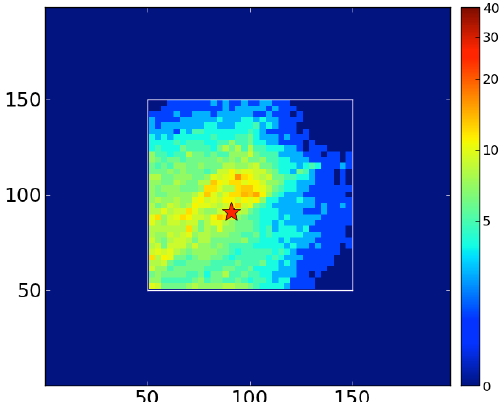
Figure 3. Reduction in uncertainty of 6-day averaged fluxes for the ) ) for CO 2 fluxes in the time 00:00–06:00UTC (100 × ( 1 − σ POST σ PRIOR case with both CO and CO 2 measurements. The red star shows the location of the power plant. The 200km × 200km domain is cen- tered at the location of Shanghai (31.2 ◦ N, 131.5 ◦